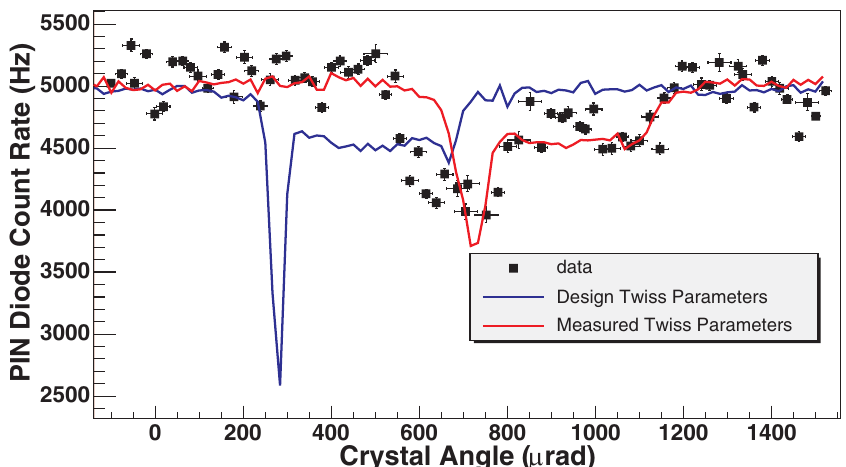
FIG. 10. (Color) Comparison of simulations with the data from Fill 1547. The distance between the crystal and beam is 29 : 0 mm .